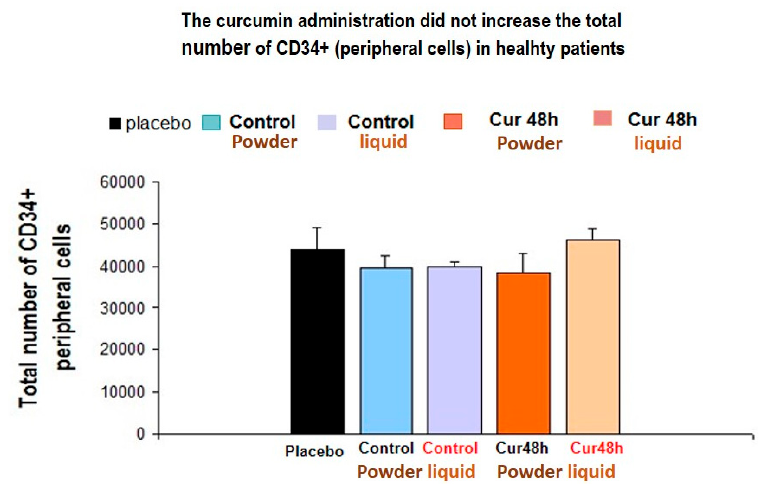
Figure 4. Curcumin treatment did not affect the total number of CD34+ peripheral cells in healthy subjects.